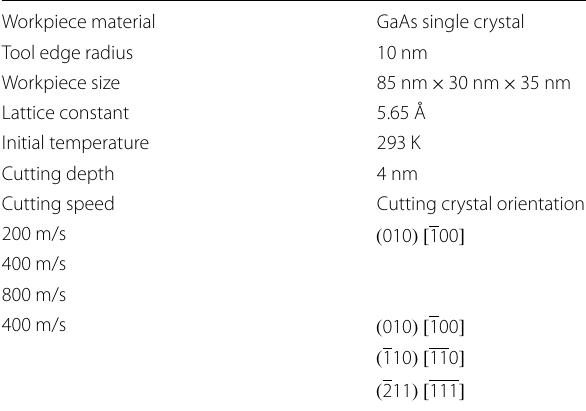
Table 1 Molecular dynamics simulation model